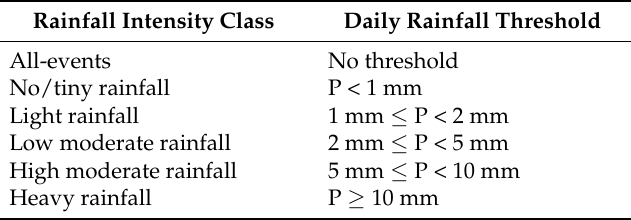
Table 6. The thresholds used for the classification of rainfall events based on the